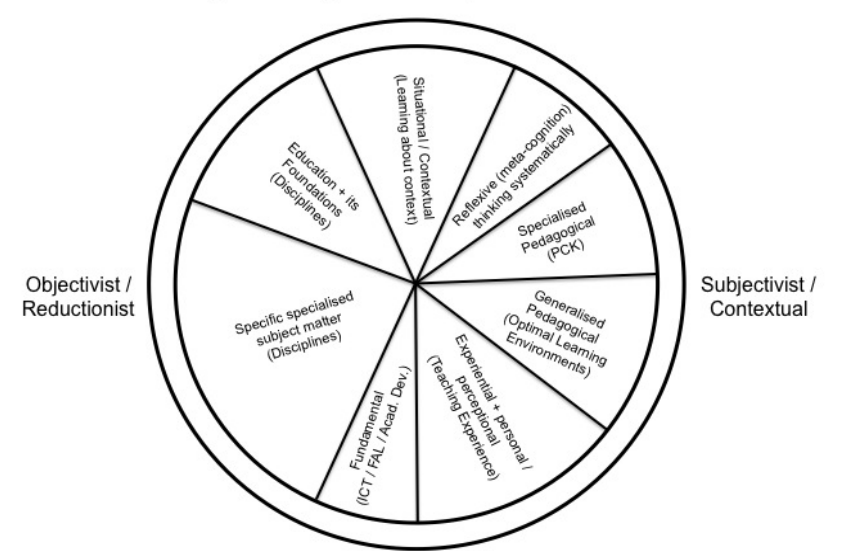
Figure. 1: Proportions of a knowledge mix for the Diploma in Grade R Teaching. (From Luckett [2001] and Korthagen